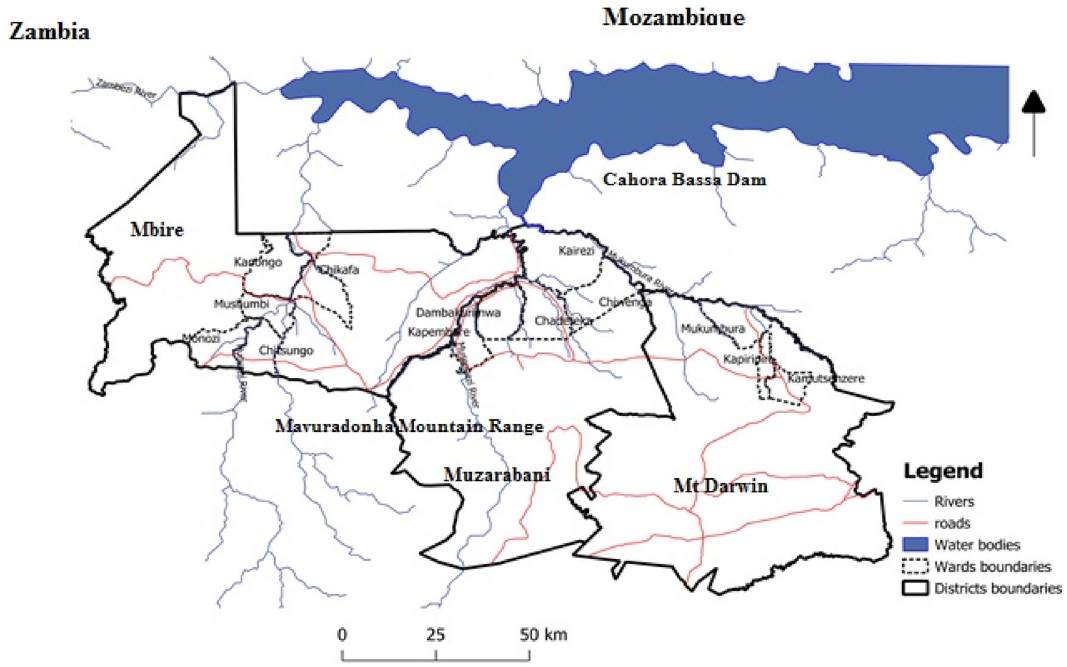
Fig. 1 The case study wards in the Mbire, Muzabarani, and Mt Darwin districts in Mashonaland Central Province of northern